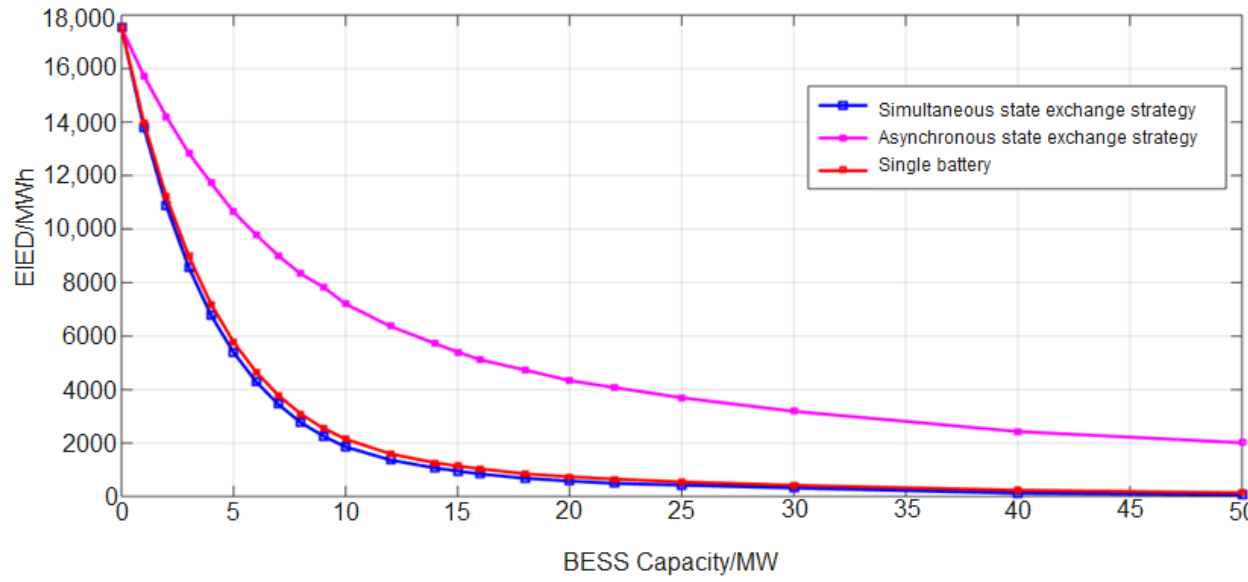
Figure 8. Probabilities of meeting generation schedule with various BESS capacities.